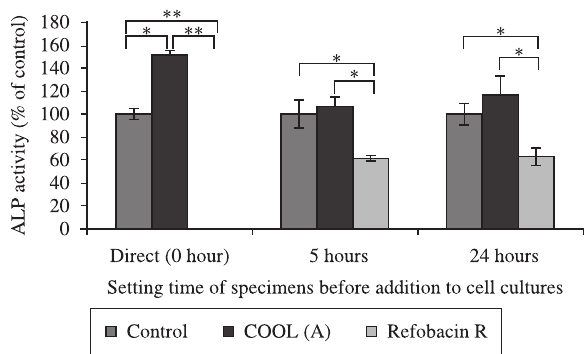
Figure 6. Proliferation of pHOB cells derived from donor 1 incubated with COOL formulation A or reference material in comparison to the control during the entire cultivation period of 16 days. a) Cement specimens were added to the cell monolayers directly after preparation and b) 24 hours after mixing. Results are the mean ± SD, n = 3). Significant differences between COOL and reference are marked with * (P < 0.05).